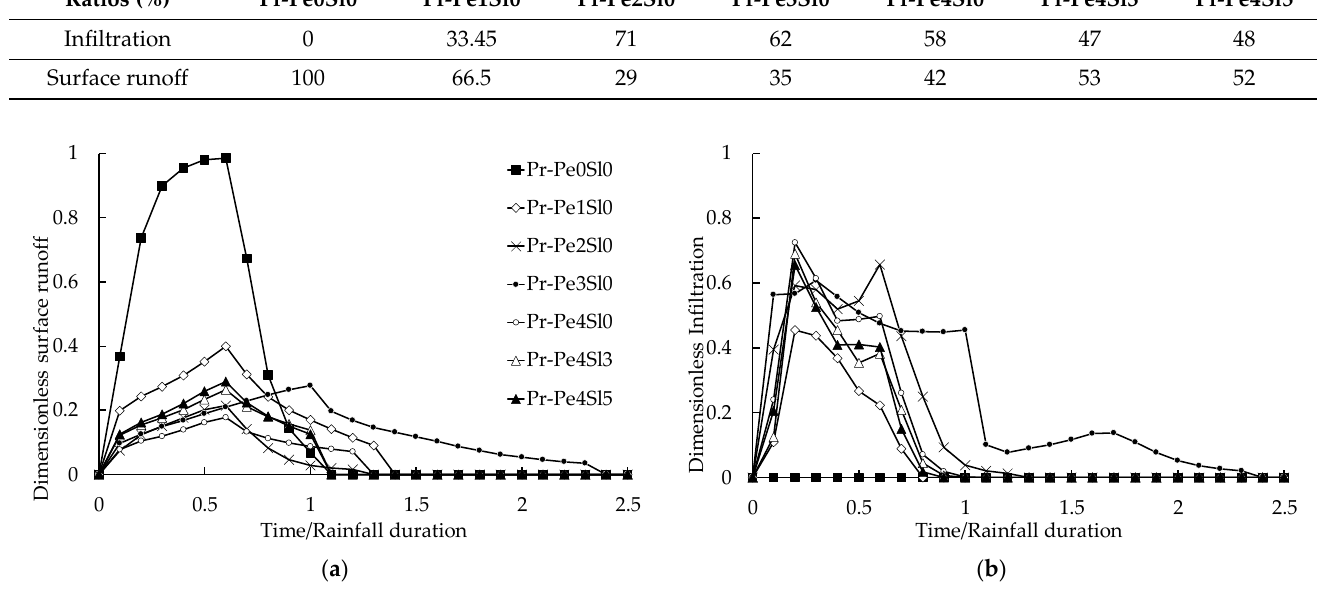
Figure 20. Results of IRD system prototype model: ( a ) infiltration; ( b ) surface runoff. Table 10. Results infiltration and surface runoff ratios. Table 11. Comparison of storage